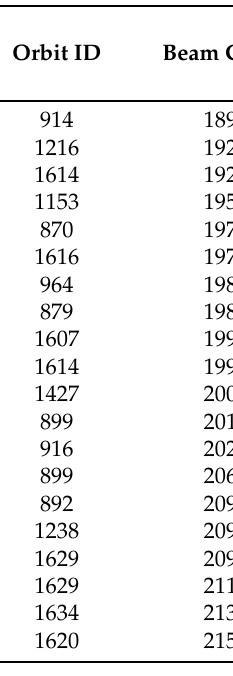
Table 1. GF3-02 SAR sea surface data